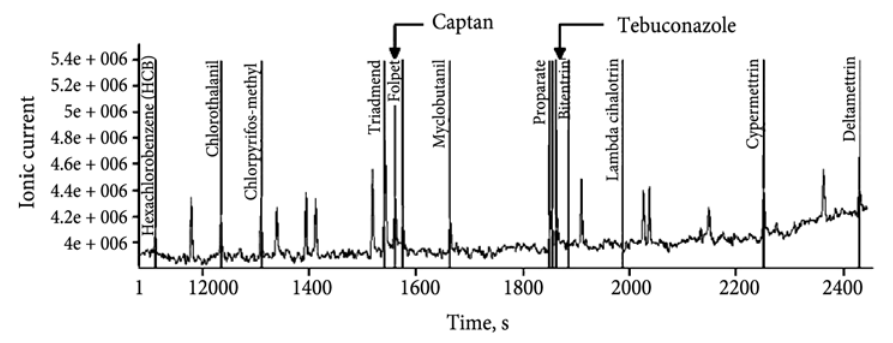
1. GC*GC-FOF-MS separation of mixture of pesticides found in the sample of